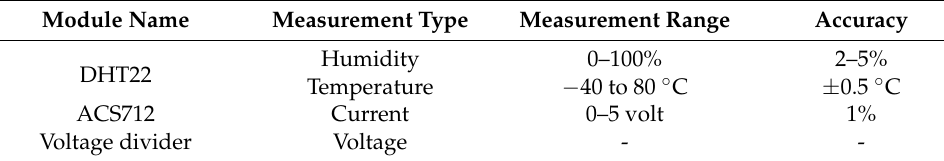
Figure 2. PV experimental setup. Table 1. Characteristics of the applied sensors.